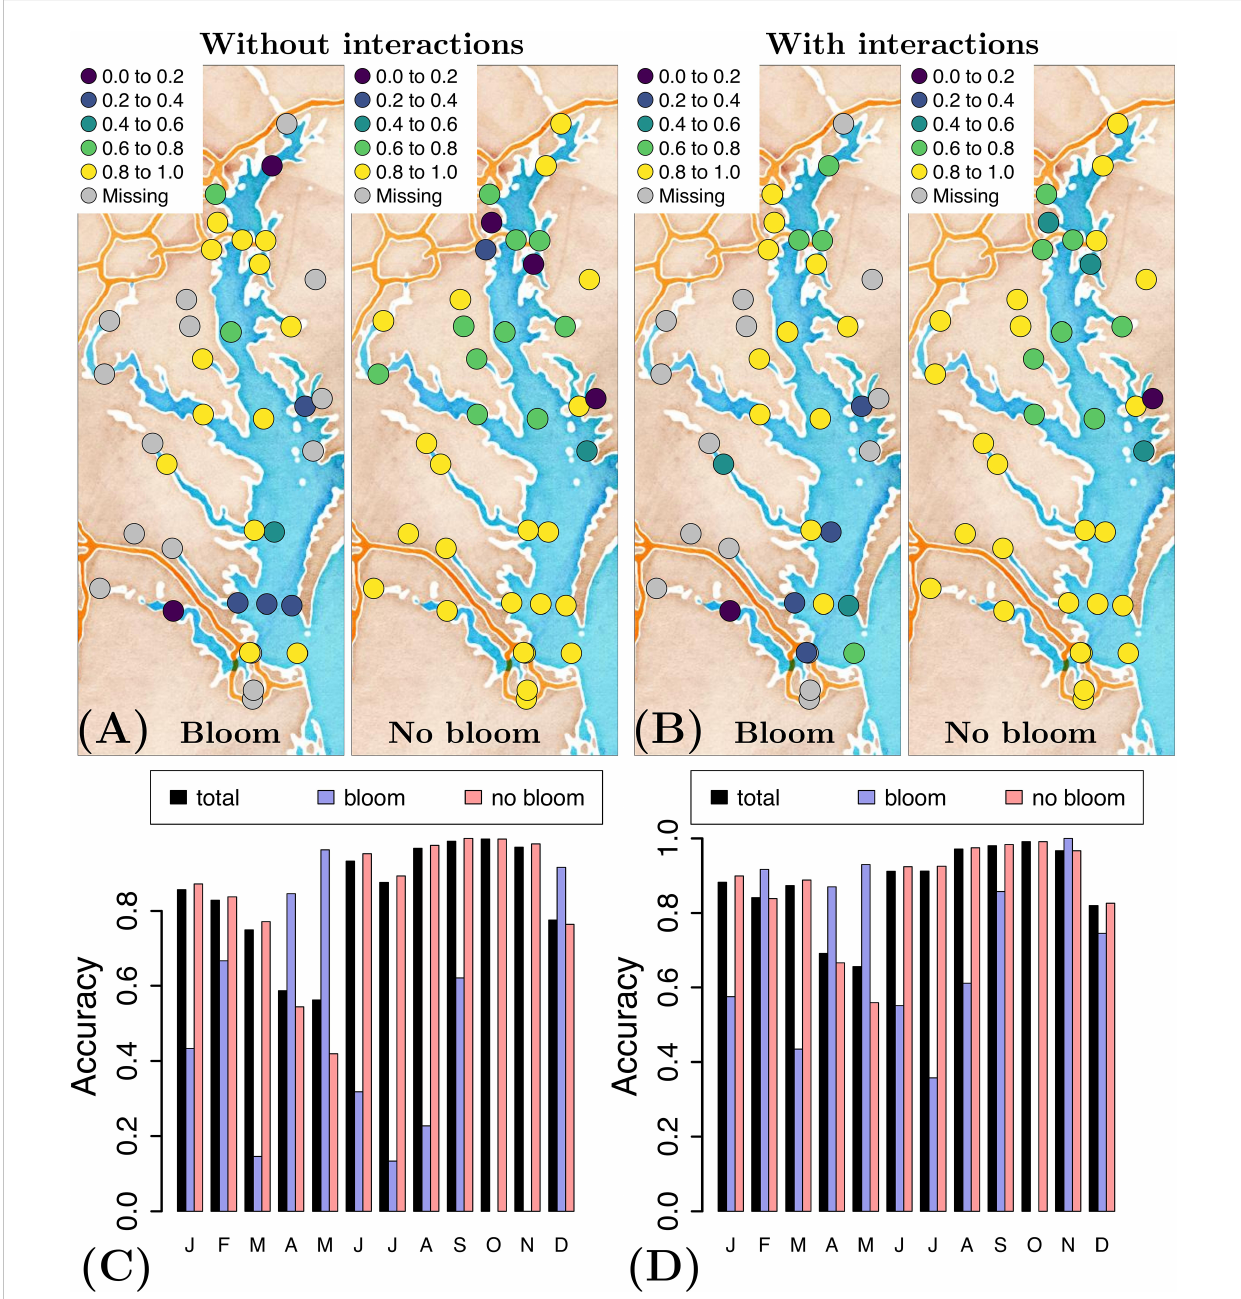
FIGURE 4 Accuracy of forecasting a P. minimum bloom and no-bloom (A) without and (B) with consideration of interactions, and the corresponding temporal distribution of the accuracy (C) without and (D) with consideration of interactions, using the optimal variable combination {T, S, pH, swrad, TON} and applying a generalized additive